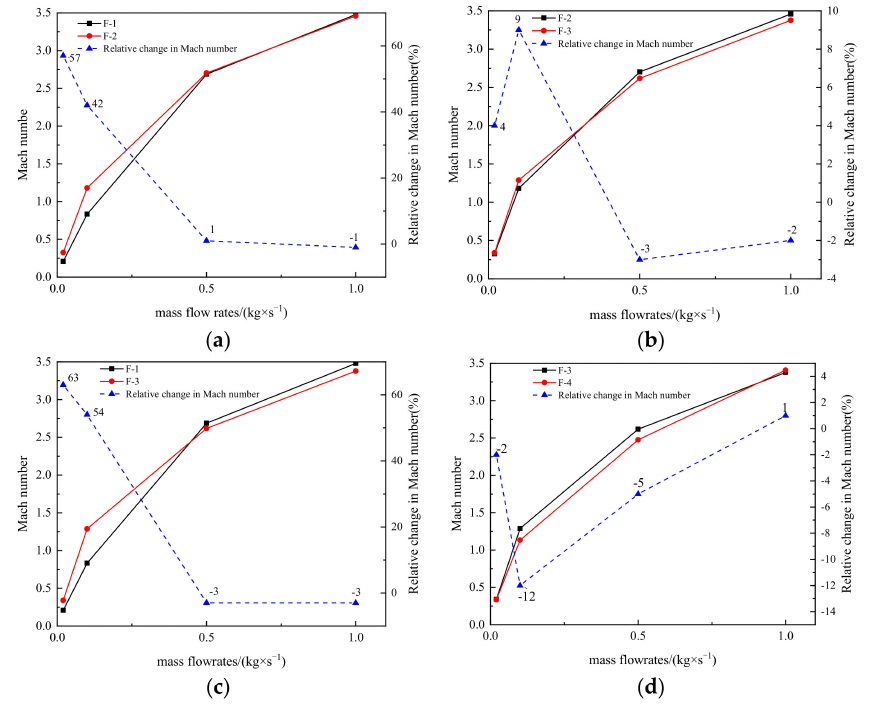
Figure 16. Relative change in Mach number of four structures under different mass flow rates. ( a ) Relative change in Mach number between F-1 and F-2. ( b ) Relative change in Mach number between F-2 and F-3. ( c ) Relative change in Mach number between F-1 and F-3. ( d ) Relative change in Mach number between F-3 and